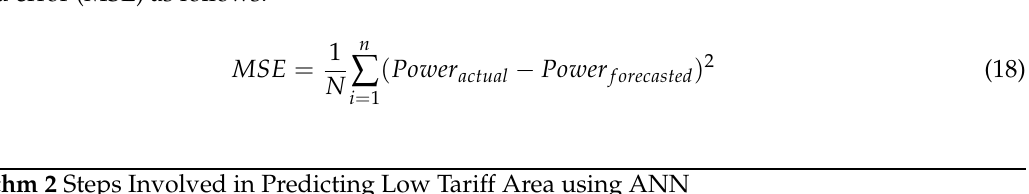
Algorithm 2 Steps Involved in Predicting Low Tariff Area using